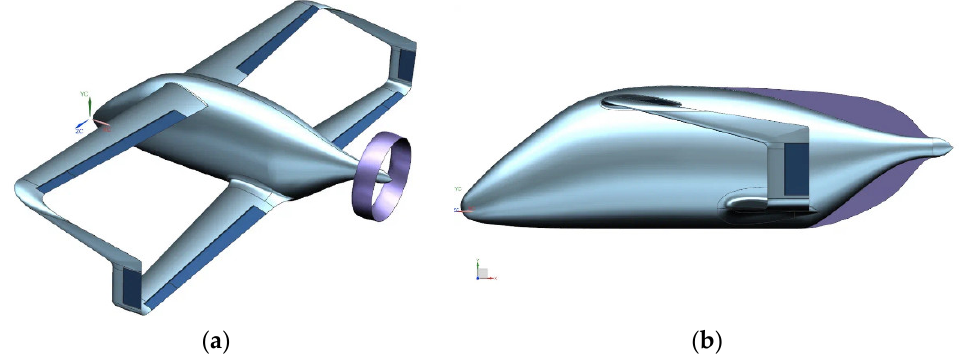
Figure 1. Tested configurations of the box-wing model equipped with ( a ) an idle duct and ( b ) vertical fishtail